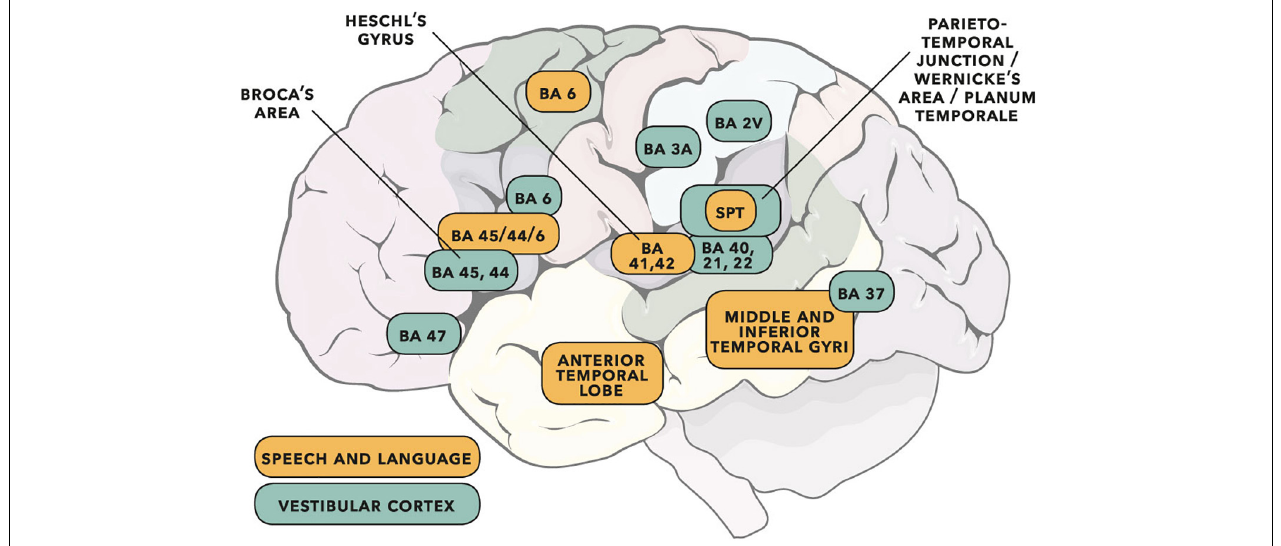
FIGURE 15 | Cortical areas important for speech and language (adapted from the dual-stream model of Hickok and Poeppel, 2007) shown with vestibular cortical areas identified in cats, monkeys and humans (adapted from Ventre-Dominey, 2014; see also Frank and Greenlee, 2018). Cortical activity following vestibular input has wide interpretation (e.g., see reviews of cognition in Hitier et al., 2014, and audition/rhythm/timing in Todd and Lee, 2015). Some of the vestibular areas identified will be predominantly related to gravitoinertial function (see discussion in Ferrè and Haggard, 2020). Numbers are Brodmann areas – see primary literature for more exact location detail. Spt is the Sylvian temporo-parietal region proposed by Hickok and Poeppel (2007) as a sensorimotor integration area. Vestibular sites in humans have been identified as such when direct electrical stimulation of the cortex gives rise to gravitoinertial illusion. When vestibular sites are identified within BA 21 (lateral temporal lobe) or BA 22 (Wernicke’s area), auditory illusion is found to accompany gravitoinertial illusion (Kahane et al., 2003; Fenoy et al., 2006). © Portions of this illustration were adapted from Servier Medical Art, https://smart.servier.com. Creative Commons 3.0